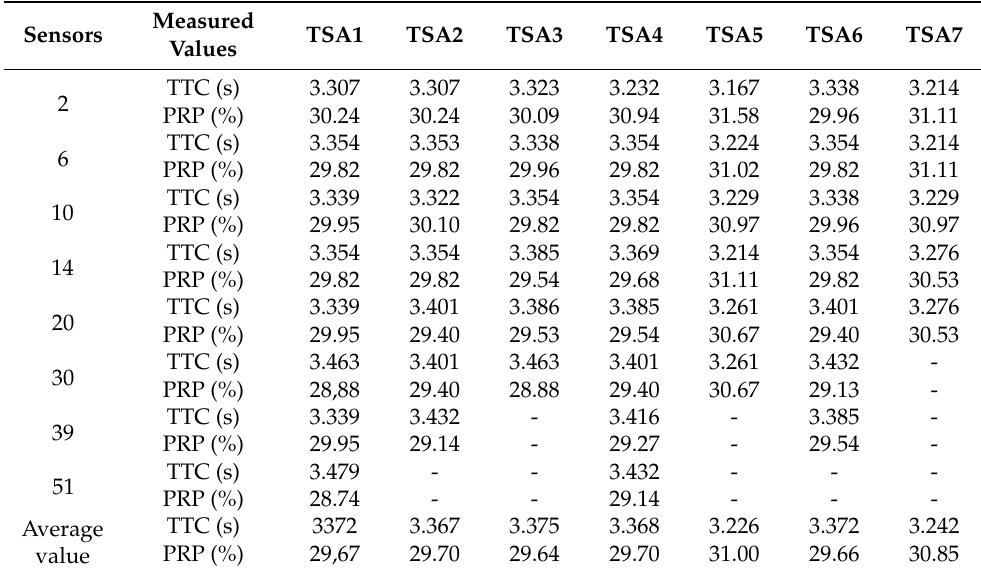
Table 5. Results of TTC and PRP timestamp issuing of TSAs in an environment with three monitoring